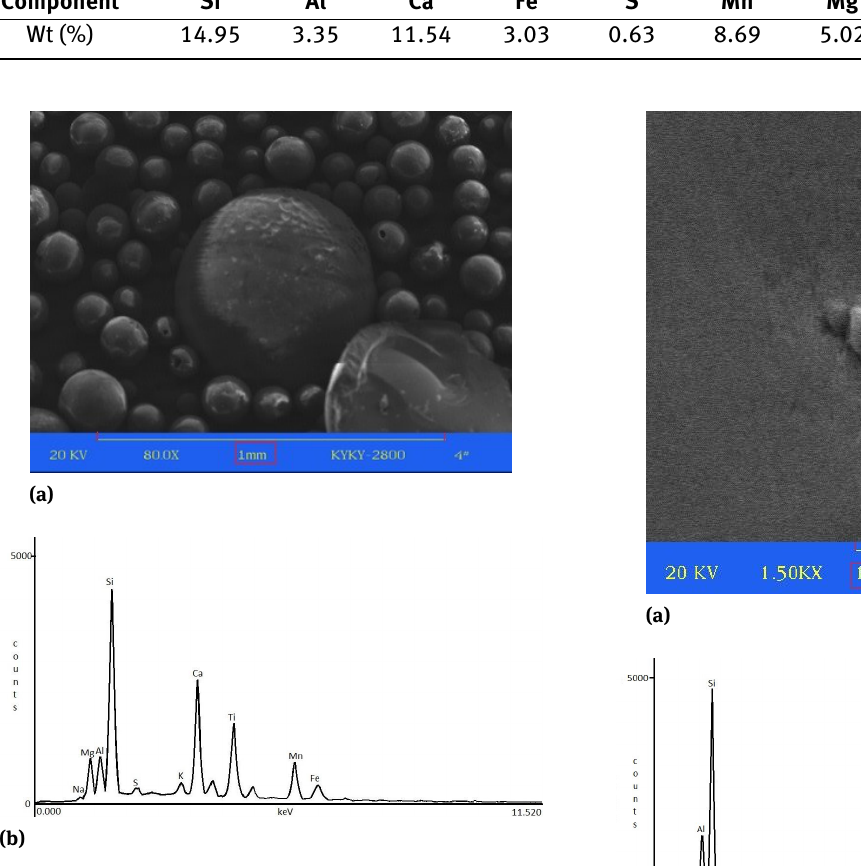
Figure 2: ( a ) Stereoscan photograph and ( b ) energy spectrum analy- sis of SiO 2 –CaO–MnO–MgO–TixOy impurity.